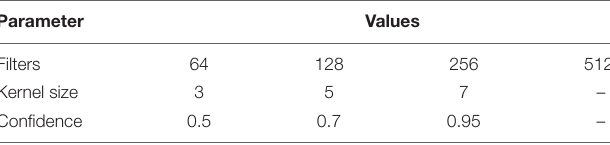
TABLE 2 | Parameter values used for grid search using the convolutional neural